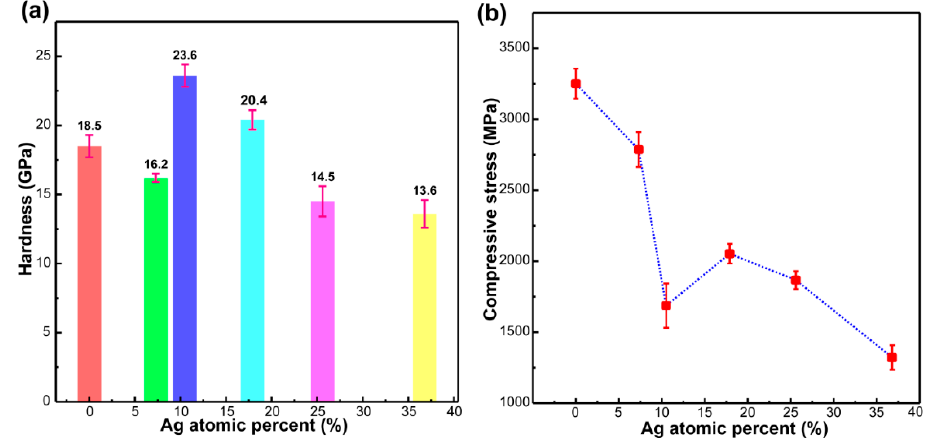
Figure 4. Variation of: ( a ) Hardness and ( b ) Stress of Ag-DLC films with Ag content.